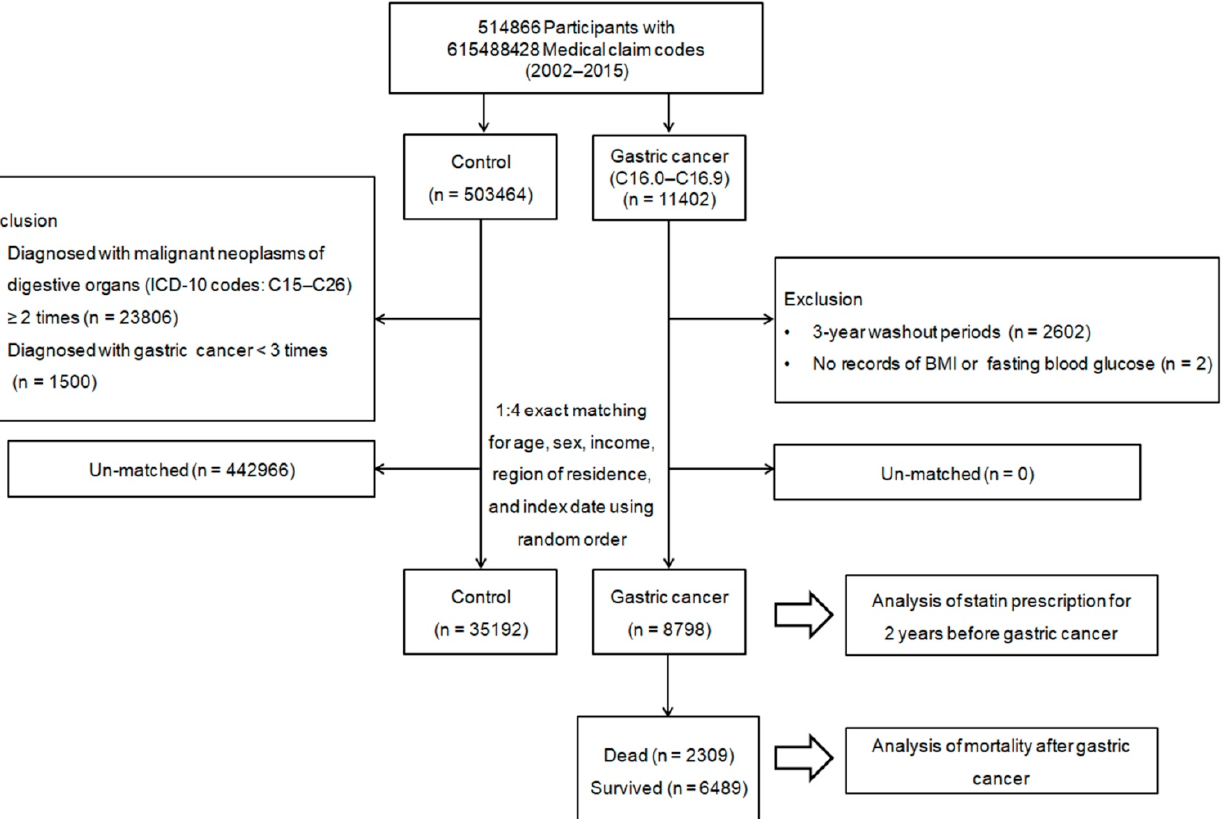
Figure 5. Flow illustration of participant selection. Of a total of 514,866 participants, 8798 gastric cancer patients were matched with 35,192 control participants for age, sex, income, and region of residence.